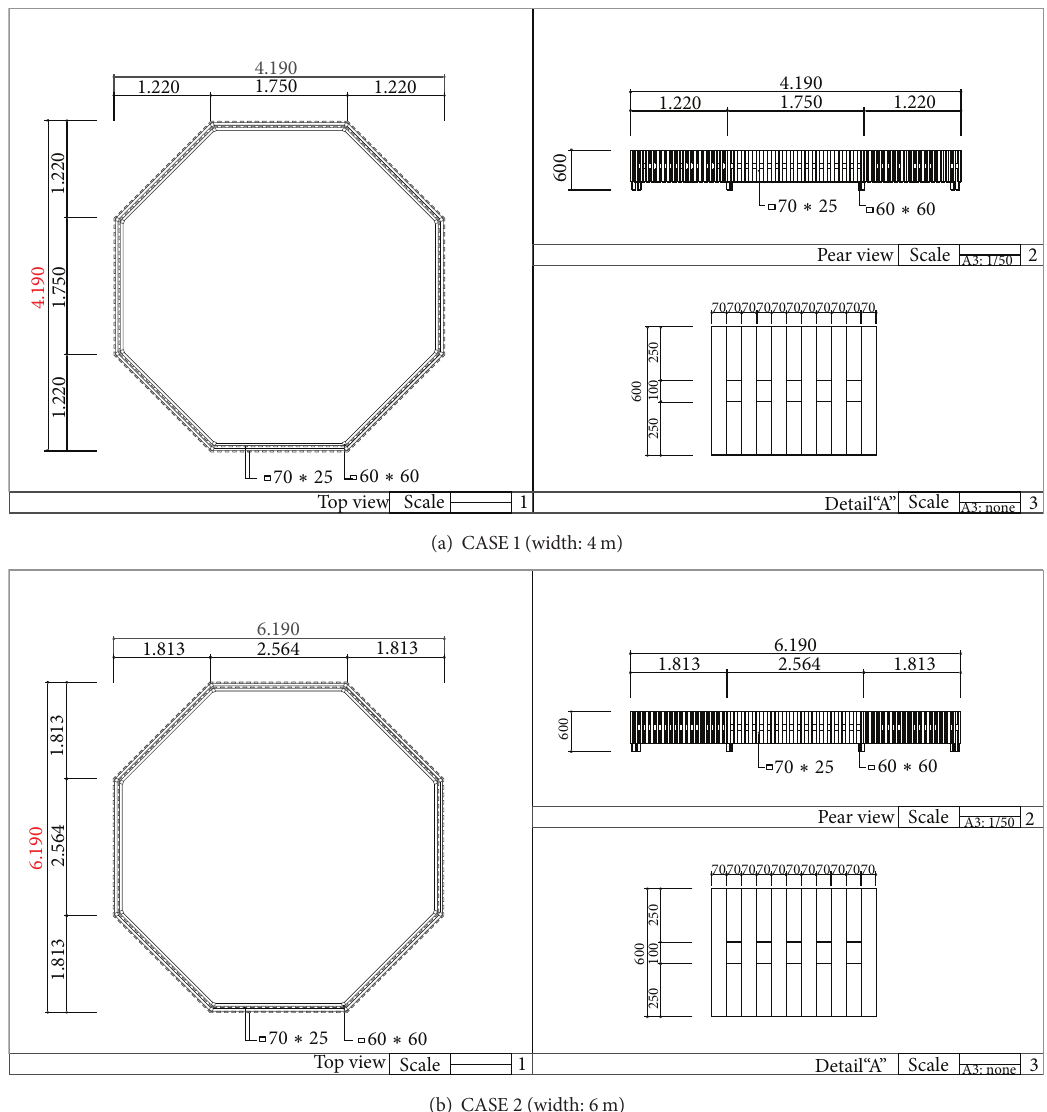
Figure 10: Specifications of the octagonal windbreak